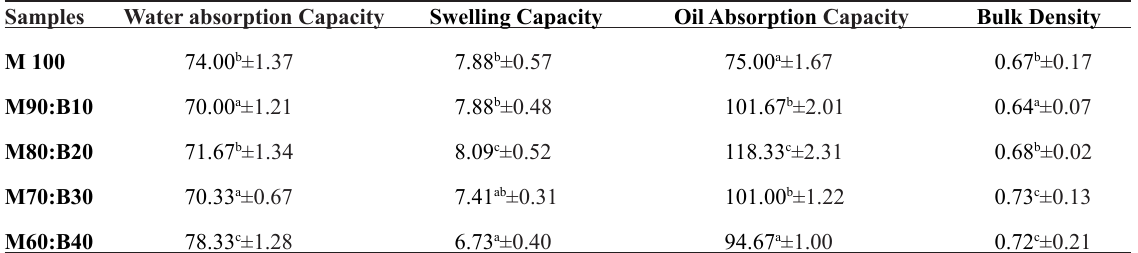
Table 5: Functional Properties of Maize-Bambara nut Composite Flours (%).